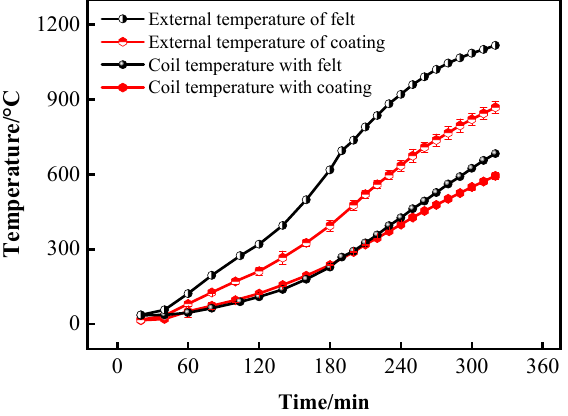
Figure 8. Temperature of the induction coil after arranging 10 mm coating and heat insulation felt.